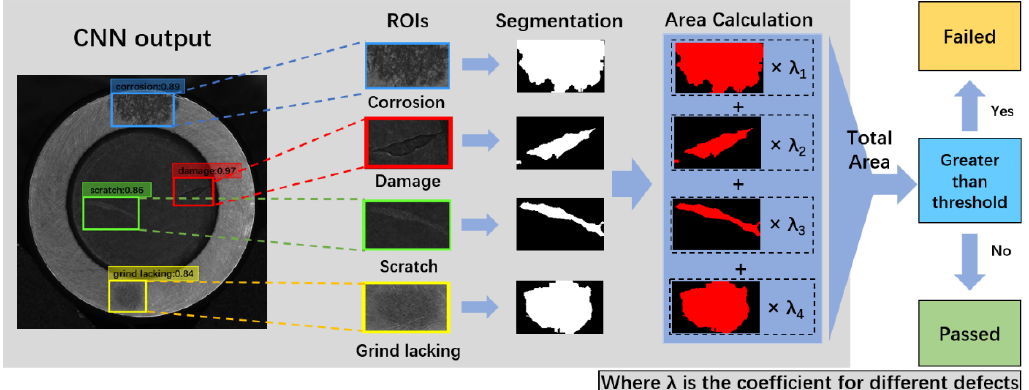
Figure 7. Roller quality determination process.